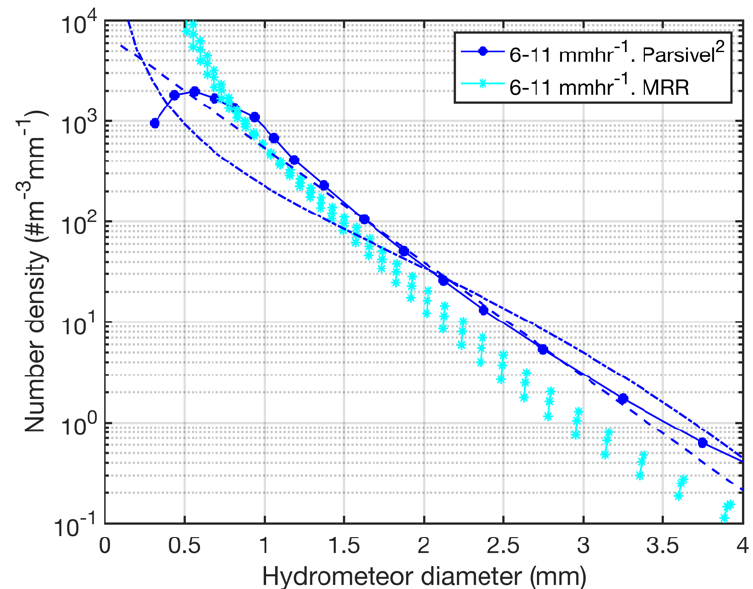
Figure 7. Mean droplet size distributions from the OTT Parsivel 2 disdrometer and the MRR sampled at 100, 200, and 300 m AGL at Bergen, Norway conditionally sampled for liquid only precipitation and a RR of 6 – 11 mmhr – 1 . Note the MRR data set covers a longer time period than the OTT Parsivel 2 . Additionally, shown are the estimates of the DSD derived using Marshall-Palmer (dashed lines) and Best approximations (dashed-dot lines) for a RR = 8.5 mmhr – 1 .